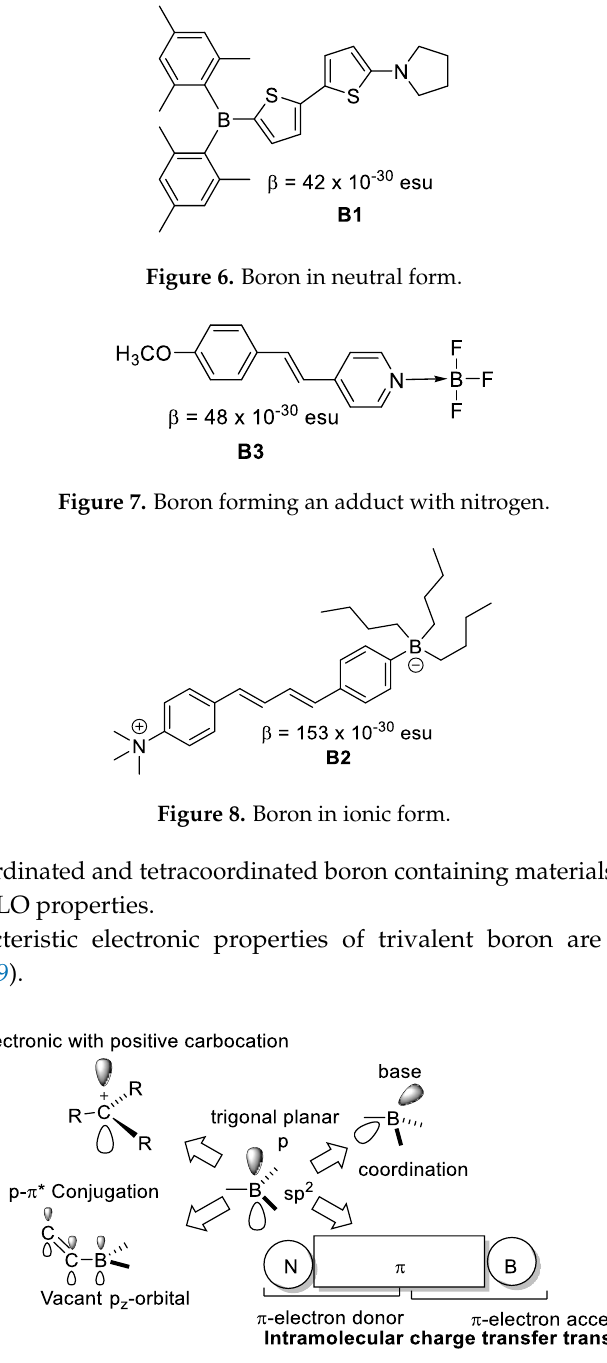
Figure 9. Main features of three-coordinated boron compounds.